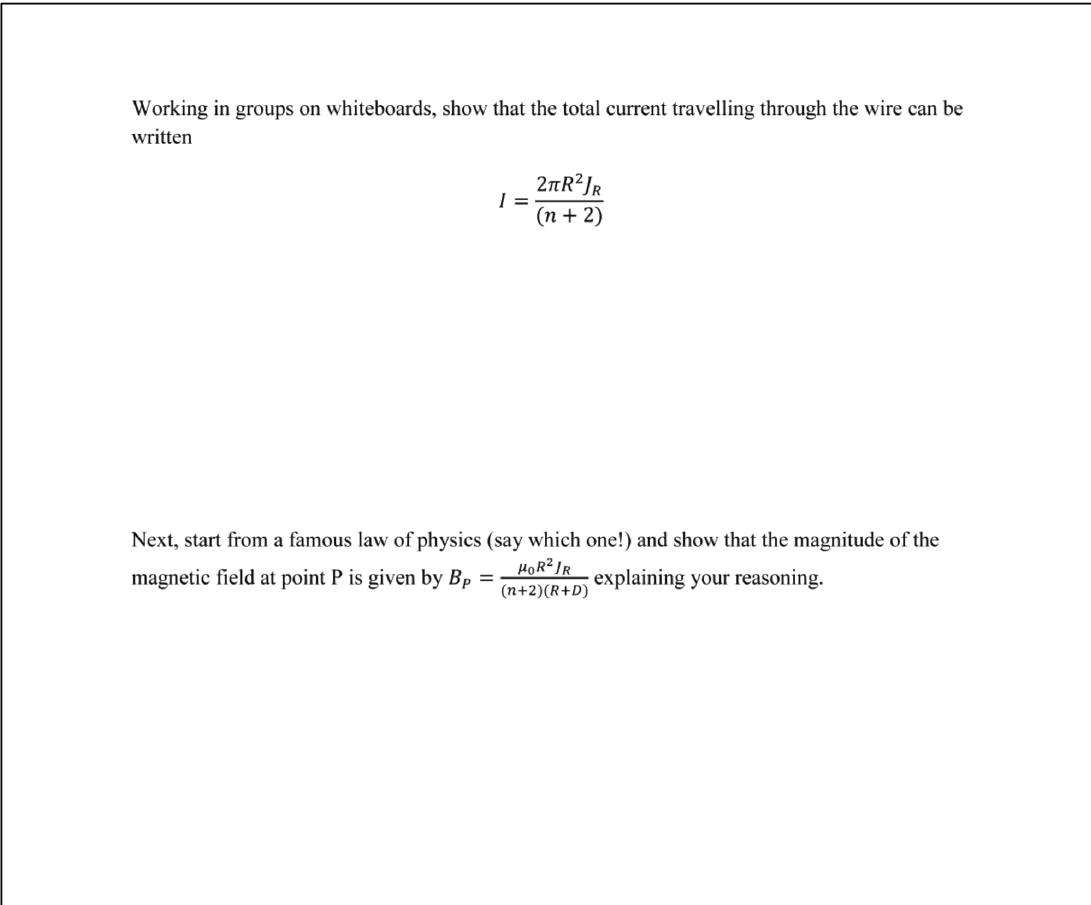
FIG. 19. Magnetic field around a conducting cylinder problem referenced in Fig. 11, layer 1, part